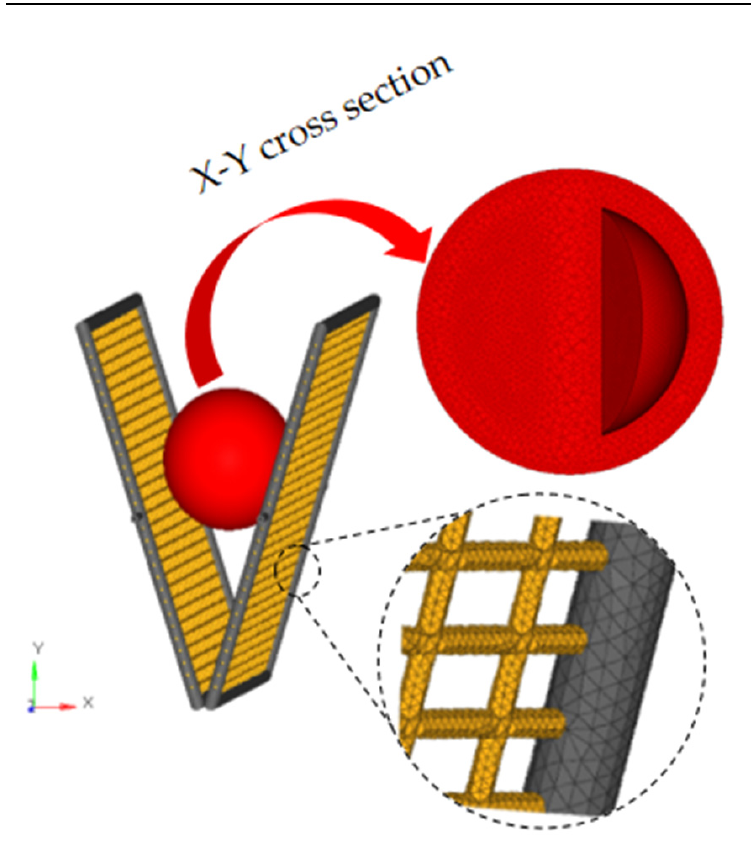
Figure 6. Condition 1 and model meshing in the simulation environment.